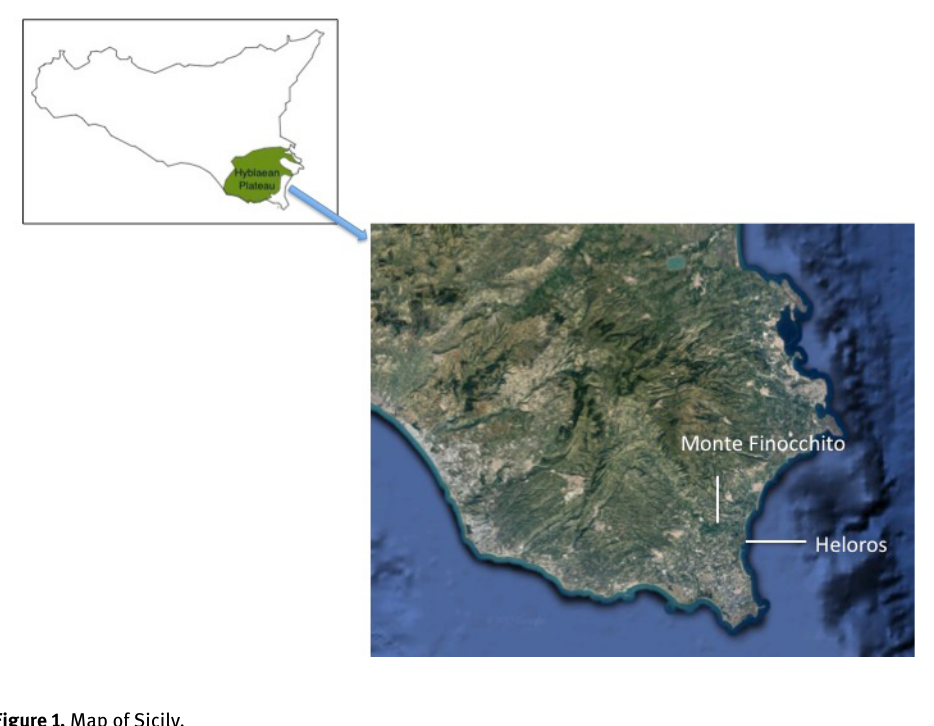
Figure 1. Map of